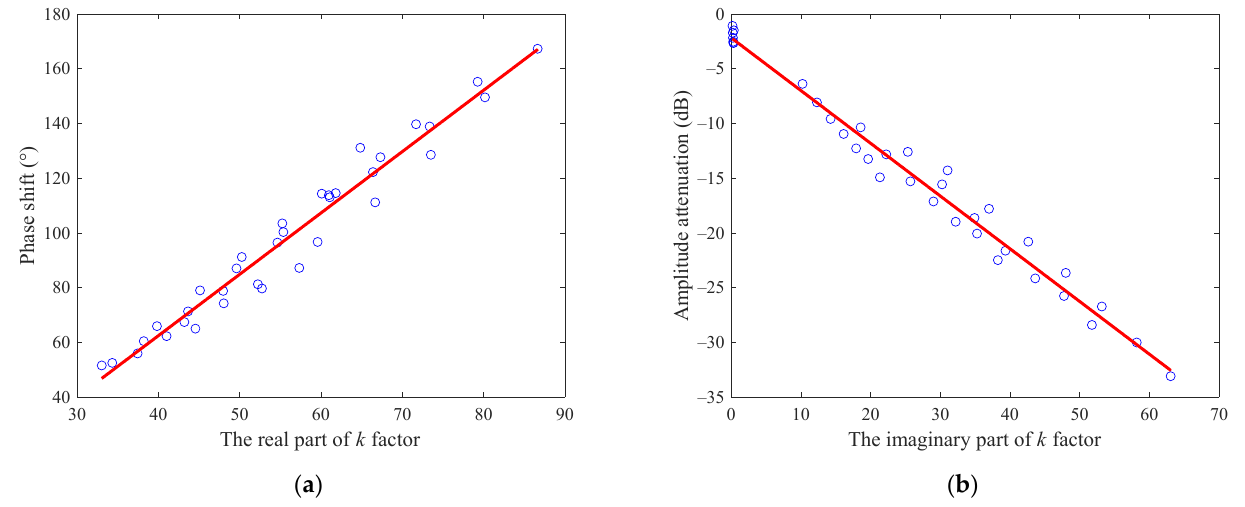
Figure 4. The linear least squares regressions of the microwave phase shift and amplitude attenuation under water-continuous conditions: ( a ) phase shift; ( b ) amplitude attenuation.